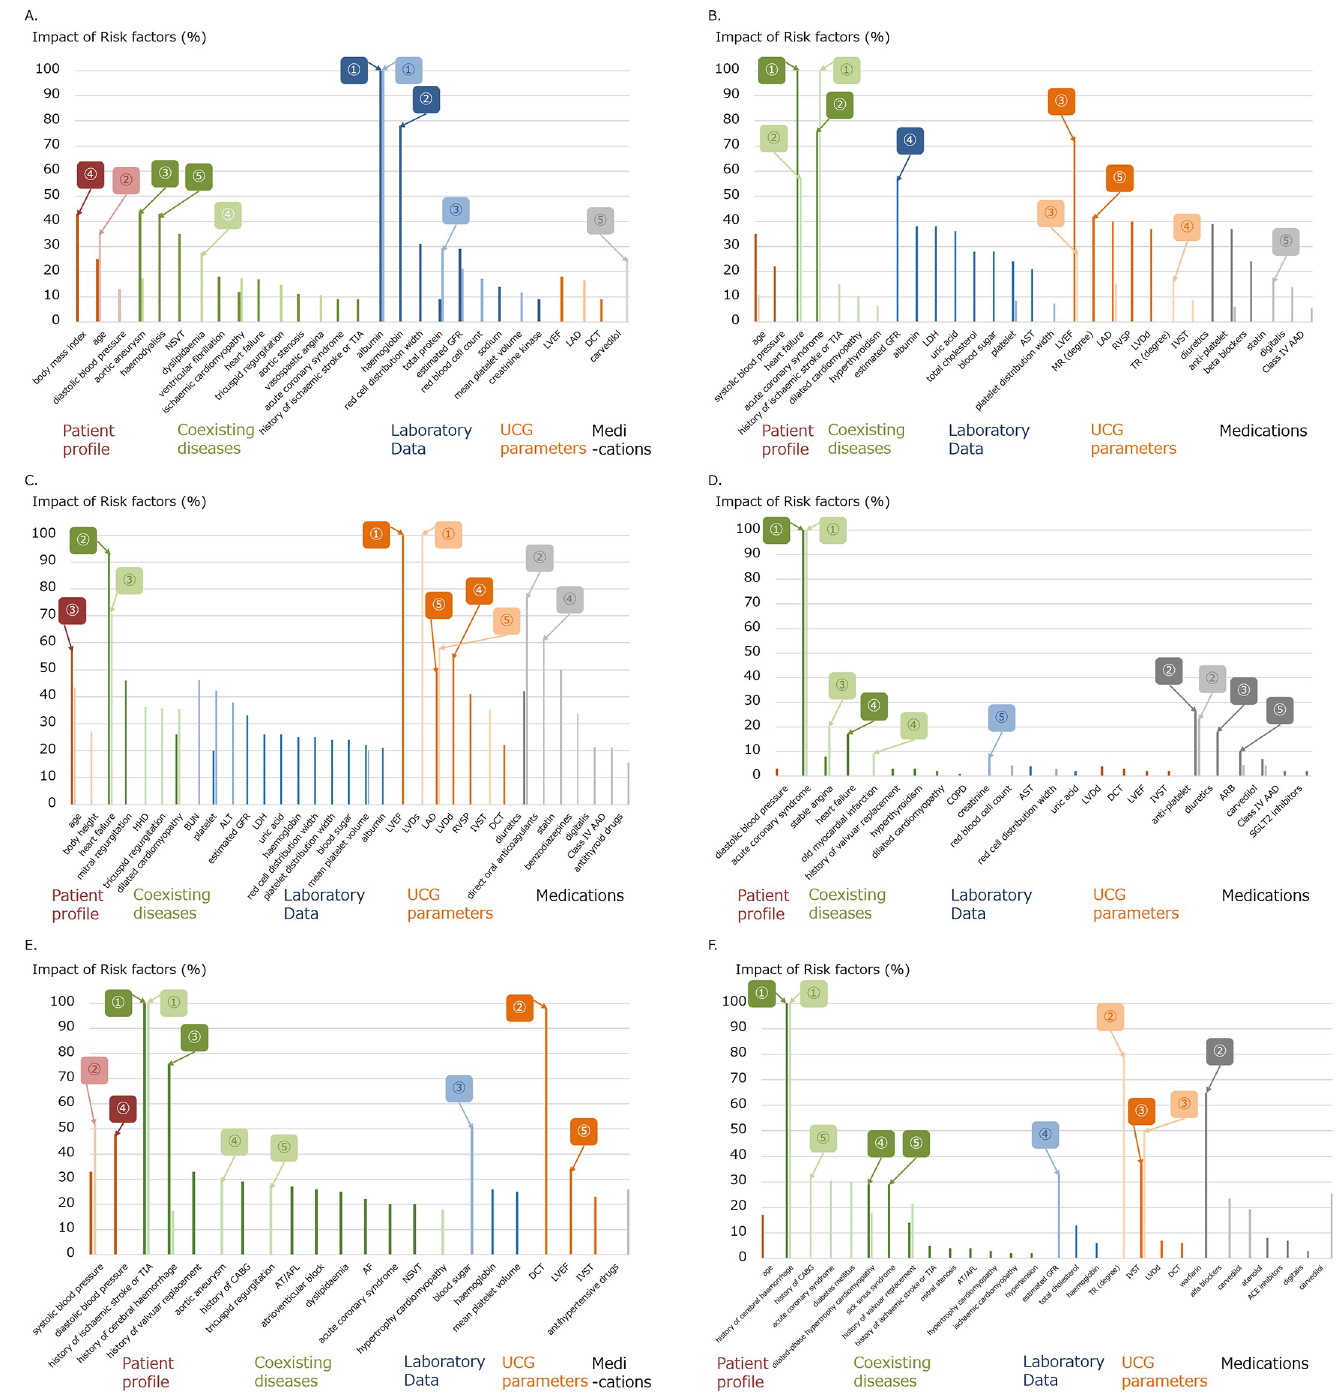
Fig 1. Impacts of risk factors selected in the prediction models with machine learning (ML) and logistic regression (LR) for six patient outcomes. (A) All-cause mortality: The areas under the curve (AUC) for all-cause mortality by prediction models with ML and LR were 0.900 and 0.881, respectively, and the risk factor with the strongest impact was albumin (impact 100, reference) for both models, followed by hemoglobin (78) and age (36) in ML and LR models, respectively. (B) Cardiovascular events: AUC 0.848 and 0.831, respectively, the risk factor with the strongest impact was heart failure and acute coronary syndrome (ACS) (both, 100, reference), followed by ACS (76) and heart failure (57), respectively. (C) Heart failure events: AUC 0.912 and 0.907, respectively, the risk factor with the strongest impact was left ventricular ejection fraction and left ventricular dimension at end-systole (both, 100, reference), respectively, followed by heart failure (93) and diuretics (77), respectively. (D) ACS: AUC 0.879 and 0.884, respectively, the risk factor with the strongest impact was ACS (100, reference) for both models, followed by anti-platelet for both models (26 and 23 in ML and LR, respectively). (E) Ischemic stroke events: AUC 0.758 and 0.757, respectively, the risk factor with the